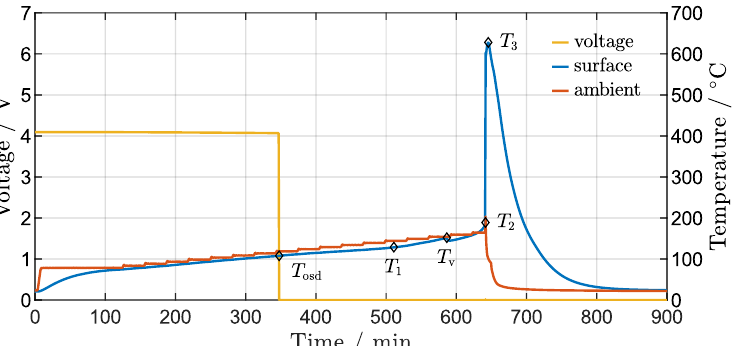
Figure 5. TR behaviour of an aged type 2 cell. Diamonds represent the five TR behaviour temperatures T 1 , T osd , T v , T 2 and T 3